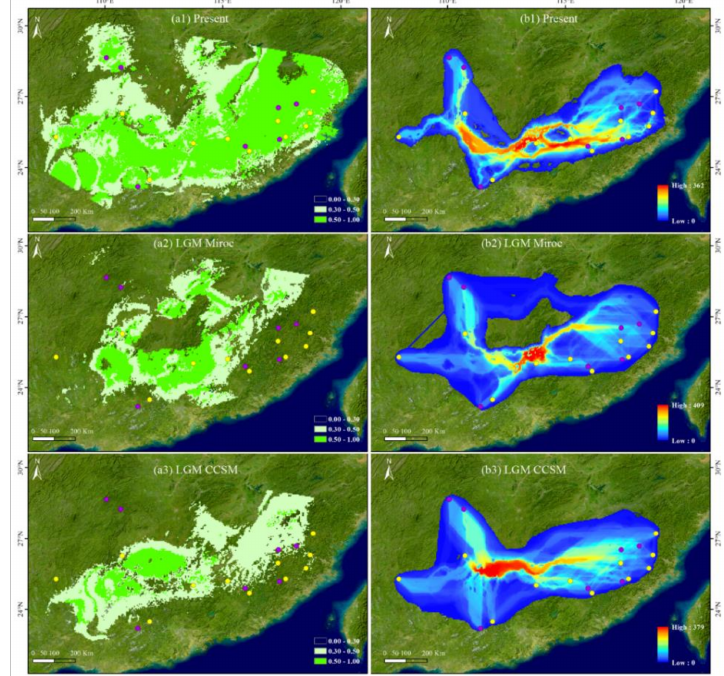
Figure 1. Potential distribution (left) and dispersal corridors (right) of Quercus chungii in the present and LGM periods. Left a1, a2 and a3 were the species potential distribution in the present, LGM period with MIROC-ESM scenarios and LGM period with CCSM v4 scenarios, respectively. Right b1, b2 and b3 were the potential dispersal corridor corresponding to a1, a2 and a3 respectively. Yellow and purple dots show the sampling sites in the fieldwork and occurrence data obtained from CVH (Chinese Virtual Herbarium; http: // www.cvh.org.cn / ), respectively. Colors in a1, a2 and a3 represent the values of species habitat suitability. Colors in b1, b2 and b3 from blue to red represent the possibility of species potential dispersal corridors from low to